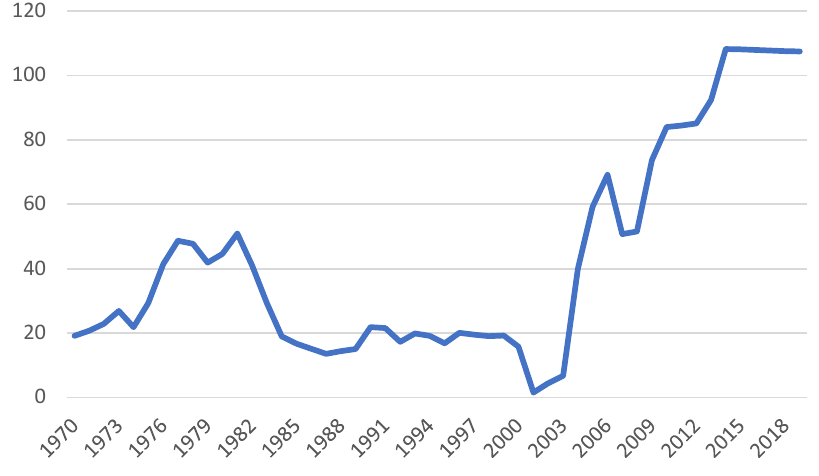
Figure 2. Private investment